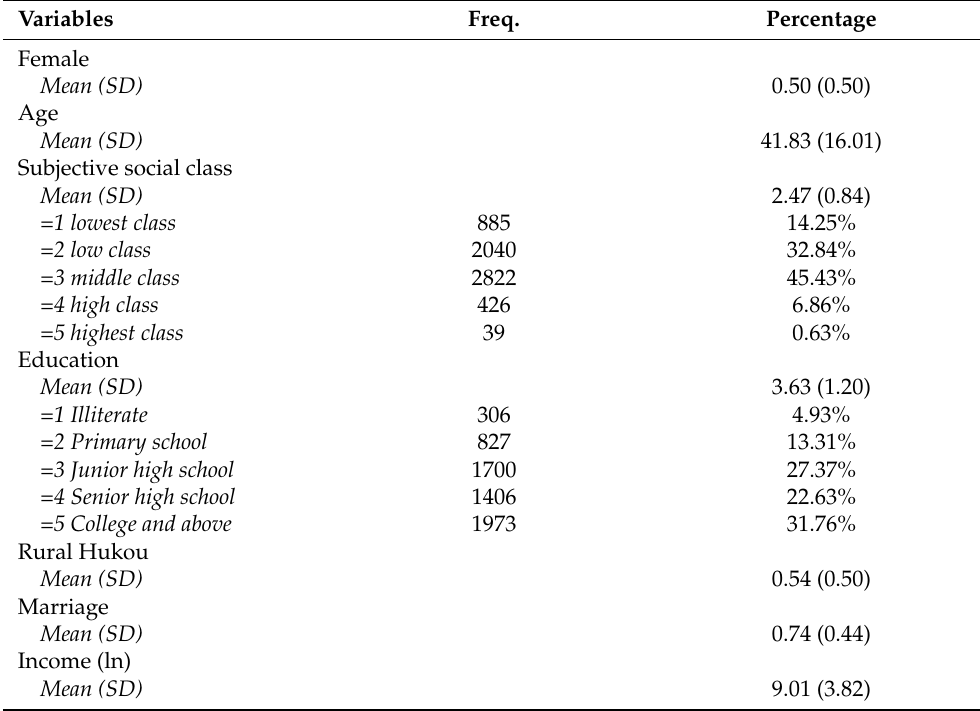
Table 2. Descriptive statistics of sampling characteristics ( n =